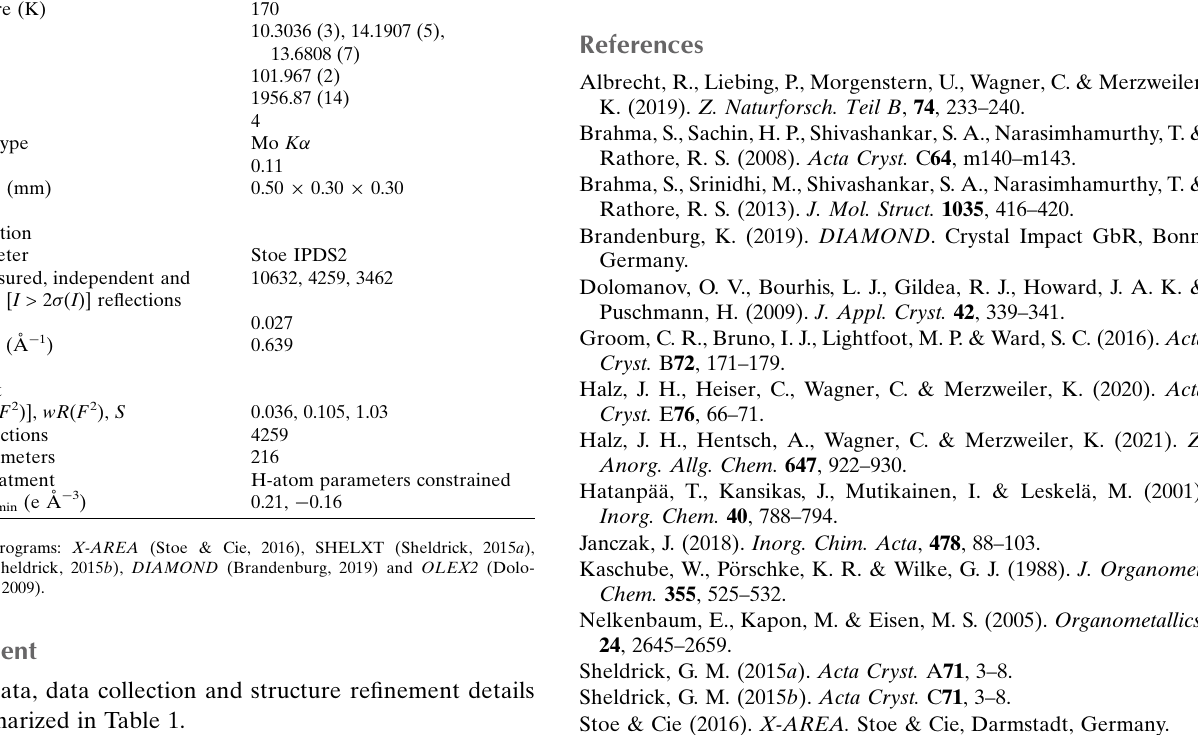
Table 1 Experimental details. Crystal data Chemical formula